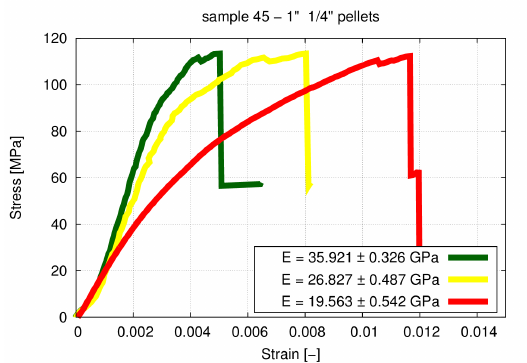
Figure 9. Stress-strain diagram of 25 × 6 mm pellets; Sample